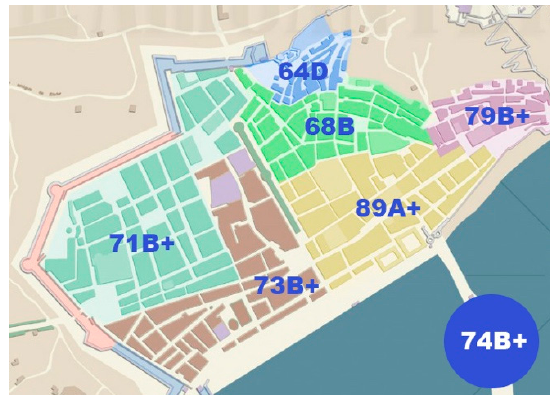
Figure 3. Simulation example of index values in a city. Number correspond to AID and letter to